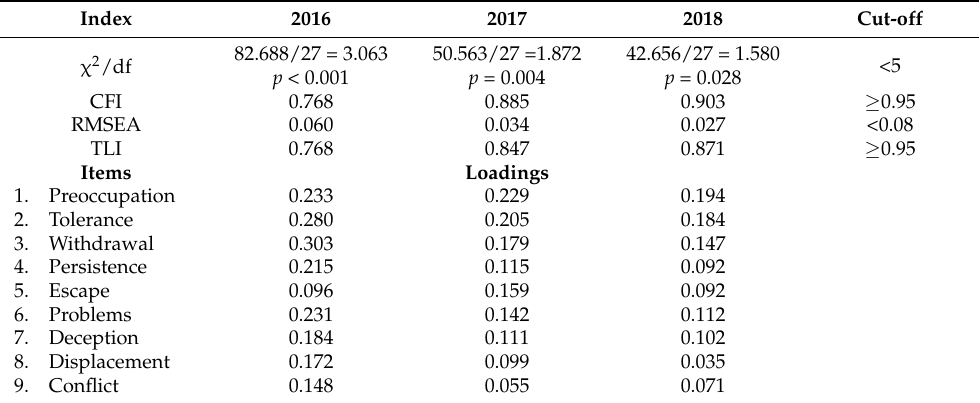
Table 3. Results of confirmatory factor analyses of the Internet Gaming Disorder Scale IGDS in three different samples plus fit indices.